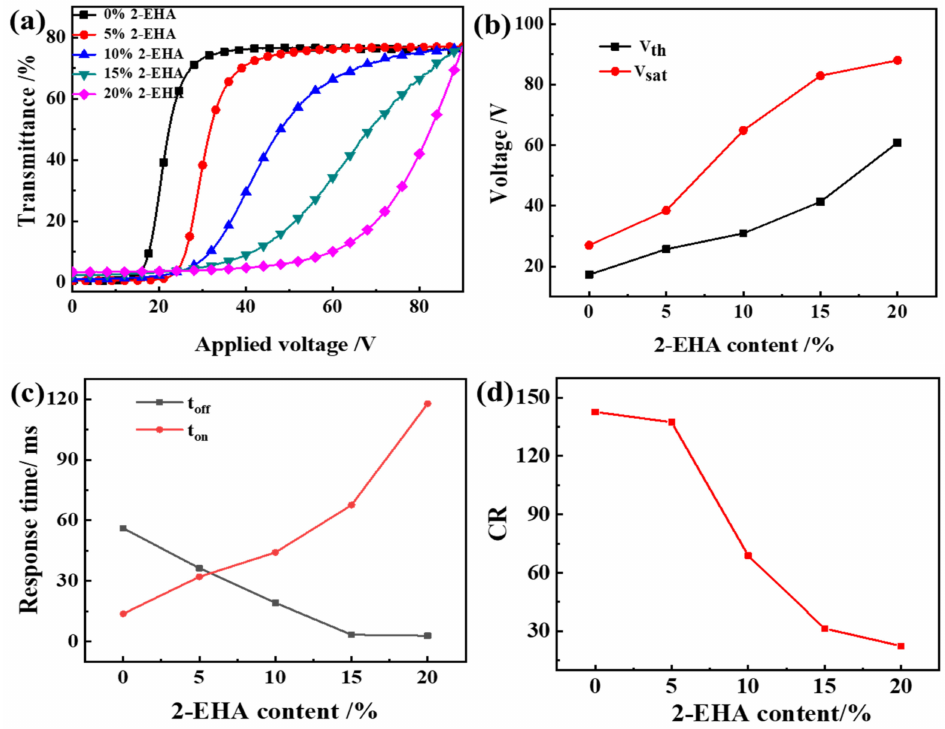
Figure 4. The effect of 2-EHA content on the electro-optical properties of PDLC ( a ) applied electric field (100 Hz) dependence of the transmittance of samples a1~a5; ( b ) V th and V sat of samples a1~a5; ( c ) Response time of samples a1~a5; ( d ) CR of samples